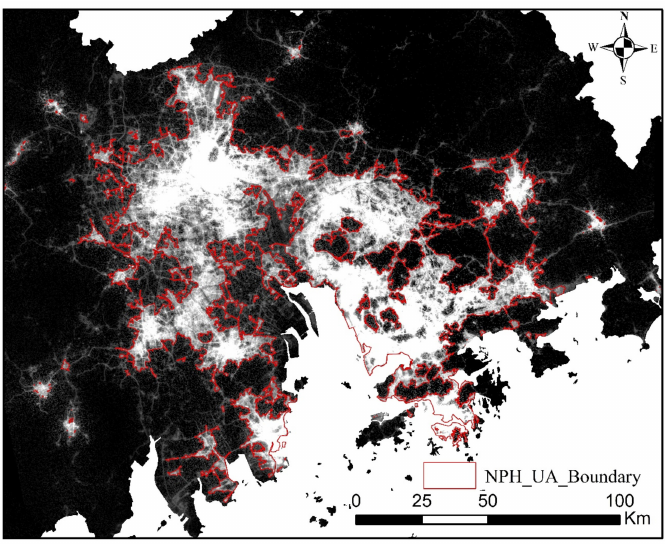
Figure 13. Urban agglomeration boundaries delineated after NTL_POI_HM